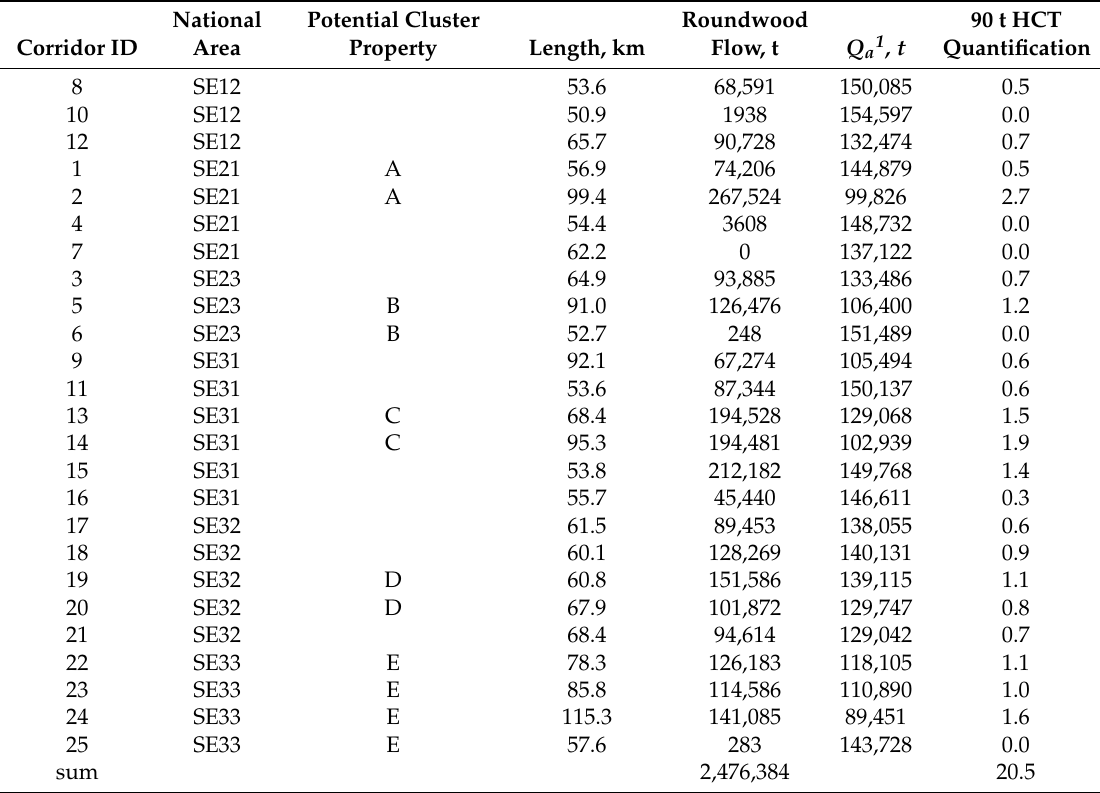
Table 6. Potential 90 t HCT corridors, cluster properties, roundwood flow and approximate vehicle